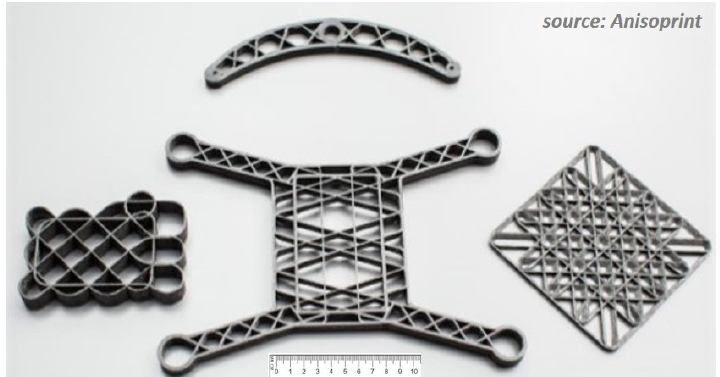
Figure 7. Three-dimensionally printed CFRP composite structural parts based on bi-matrix TS-TP FFF